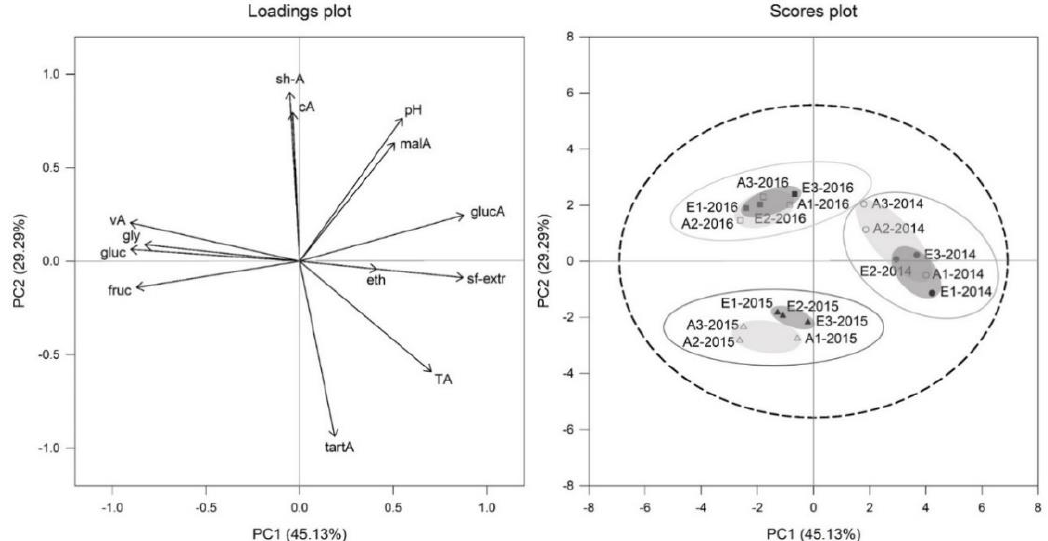
Figure 3. Loadings and scores plot of principal component analysis (PCA) of Cabernet Sauvignon must parameters from aCO 2 (open symbols) and eCO 2 (filled symbols) treatment for the years 2014 (circles), 2015 (triangles) and 2016 (squares). Data represent mean values per ring and p = 0.95 for confidence level (dashed line).